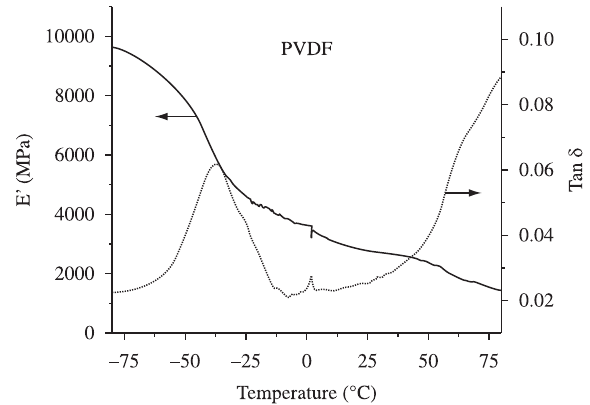
Figure 8. The DMA measured storage modulus and tan δ of the PVDF.